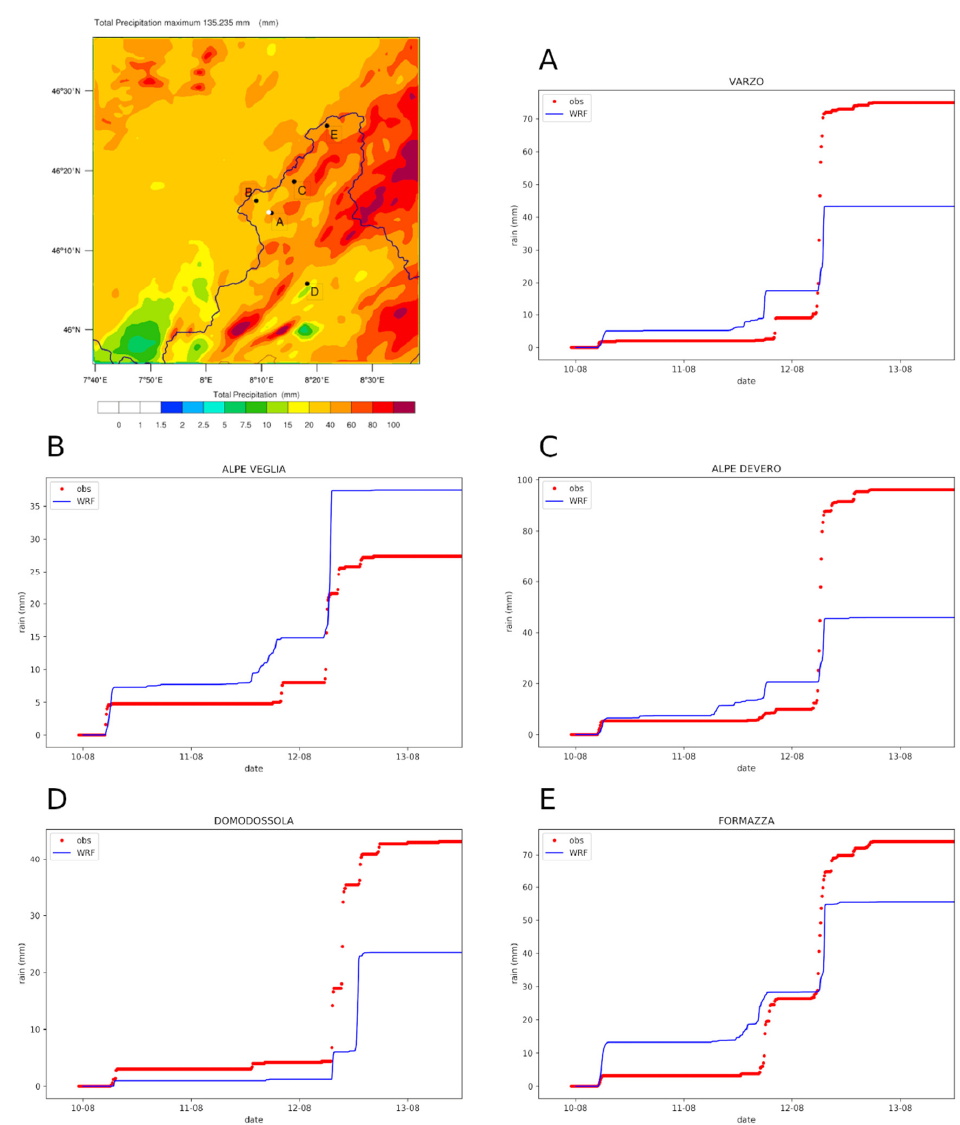
Figure 9. Comparison of simulated (blue lines) and observed (red dots) precipitations at station locations. The top-left panel represents the total simulated precipitation during the period 10 th to 15 th August 2019. Letters of panels and on the cumulated precipitation plot refer to Table 1. The white dot on the upper left panel indicates the position of Croso stream bridge.